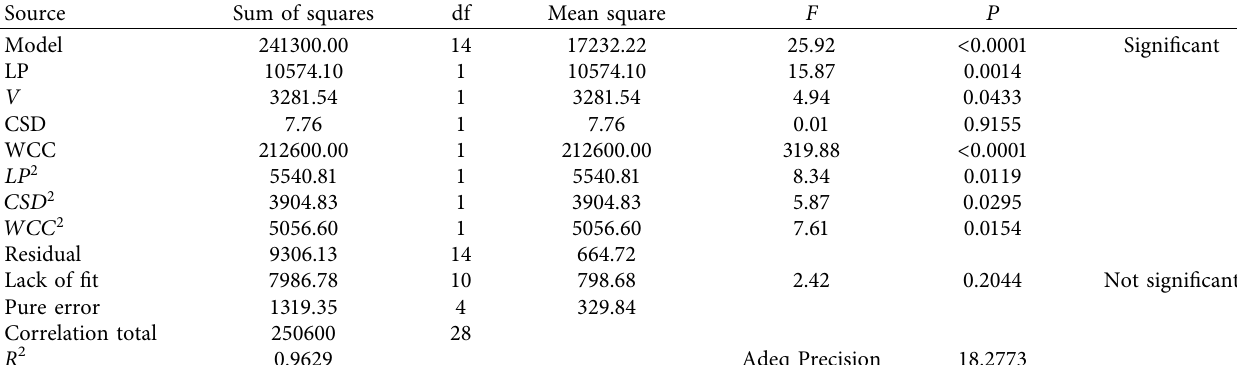
Table 7: Variance analysis of the hardness of the cladding layer.